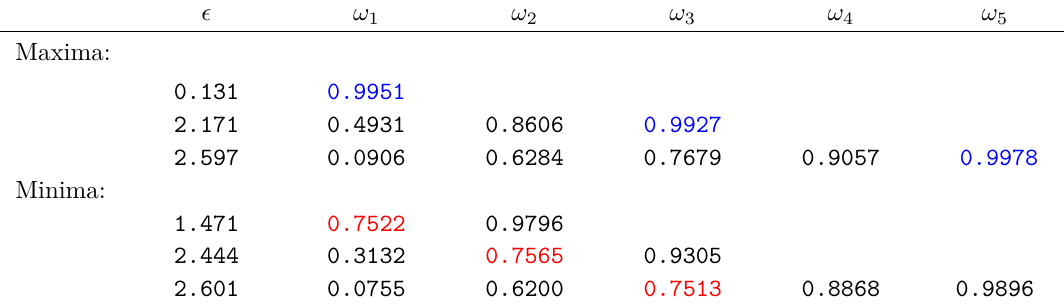
Table 2 . Spectral structure at extreme